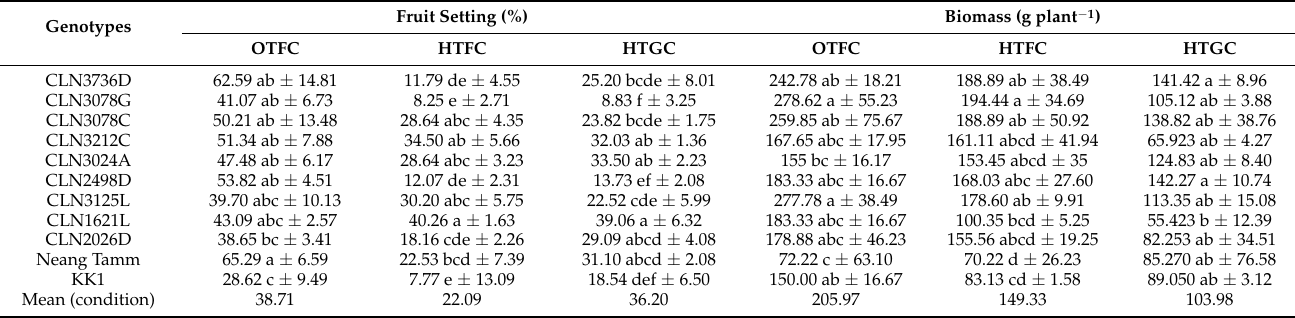
Table 3. Fruit setting and plant biomass of tomato genotypes under optimal temperature field condition (OTFC), high temperature field condition (HTFC), and high temperature greenhouse condition (HTGC).